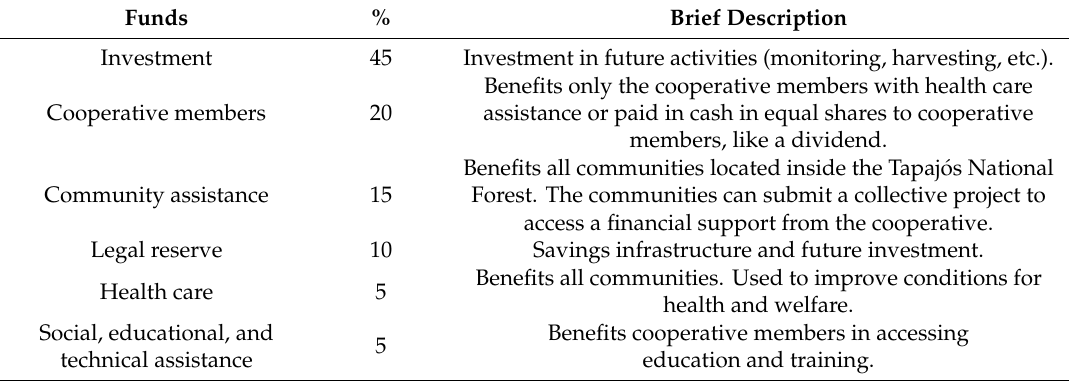
Table 3. Financial benefits distribution from the community-based forest enterprise, according to statutory regulations, approved at the General